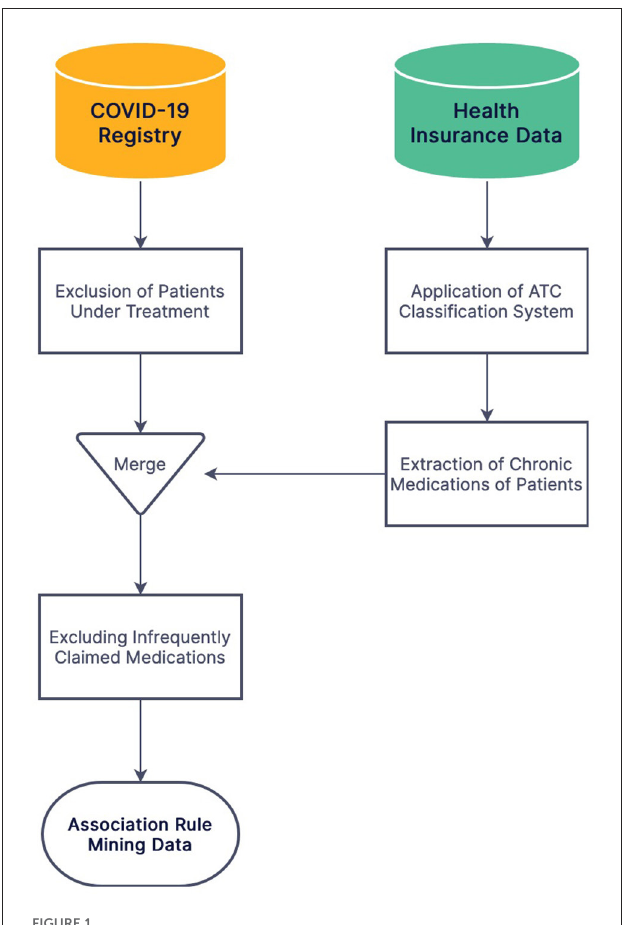
FIGURE1 The flowchart of data preprocessing and merging stages of the Iranian COVID-19 registry and IHIO.